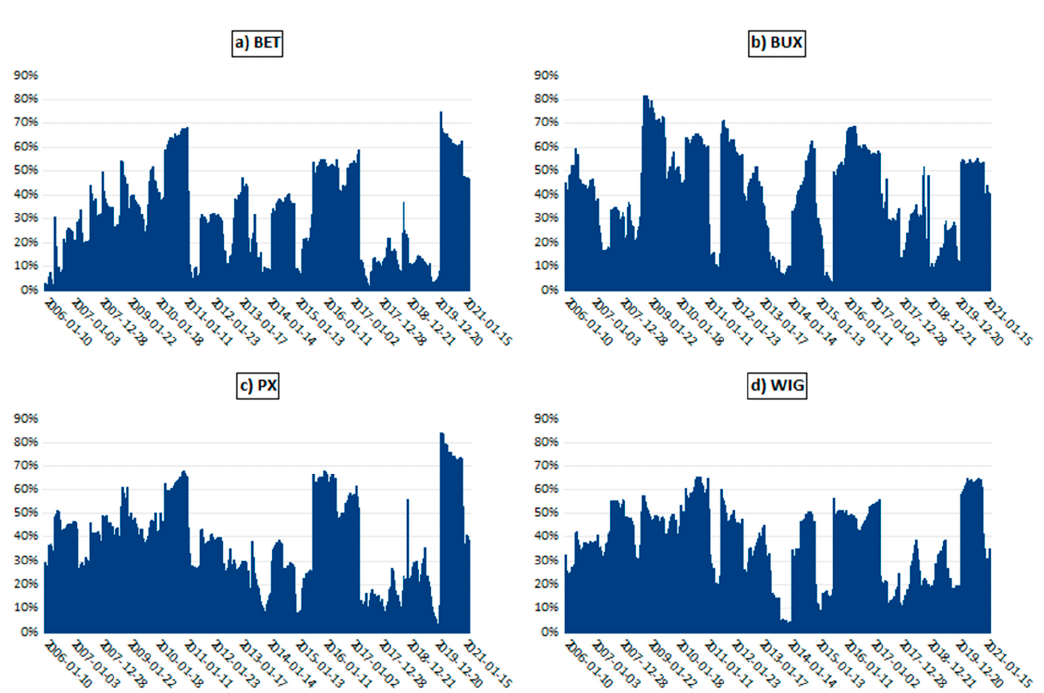
Figure A8. Directional Volatility Spillovers Received by Each Stock Market Index from All the Other Three Indices.